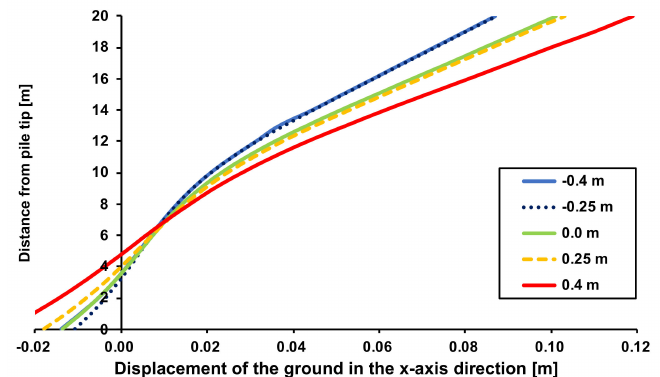
Figure 12. Displacements of new pile at installing position.